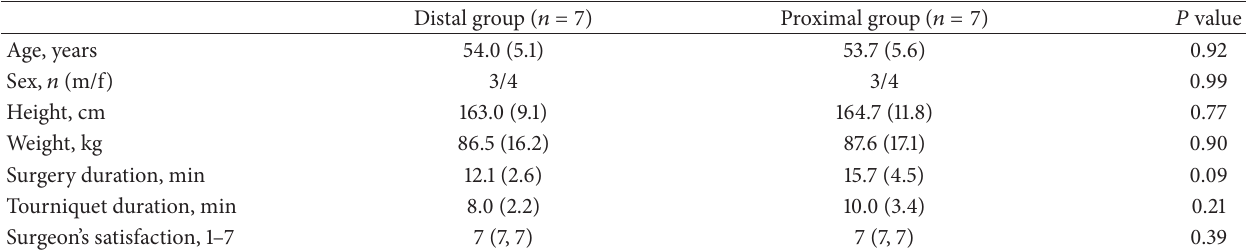
Table 1: Demographic and surgical